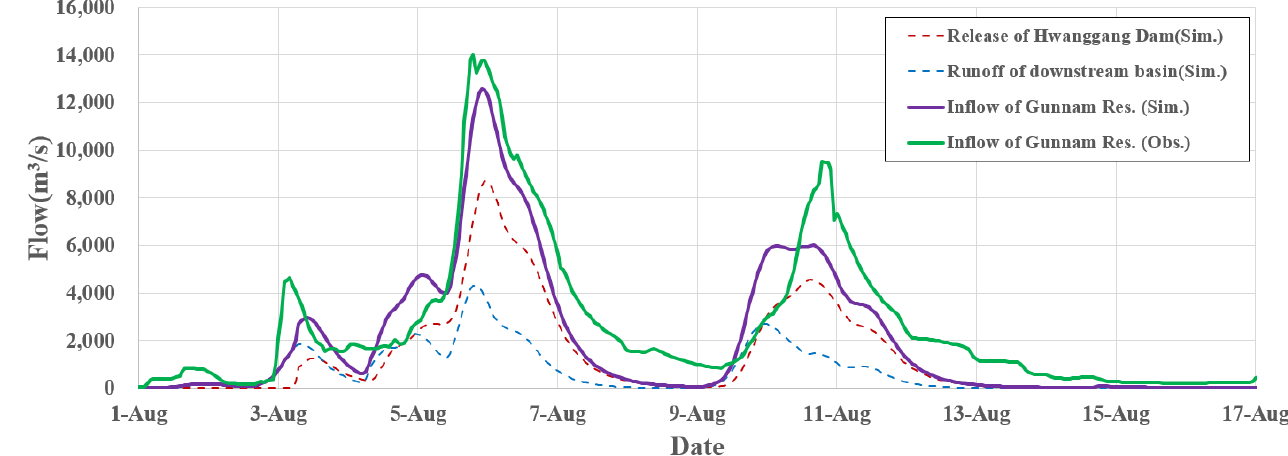
Figure 12. The time series simulation of the Gunnam Flood Control Reservoir; the red dashed line represents the release from the Hwanggang Dam derived by the Auto-ROM algorithm; the blue dashed line represents the runoff from the basin between the Hwanggang Dam and the Gunnam Dam; the purple line represents the flood inflow of Gunnam Flood Control Reservoir by simulation; the green line represents the observed inflow of the Gunnam Flood Control Reservoir. The sum of the red and blue dashed line contributes eventually to the inflow to the Gunnam Dam.